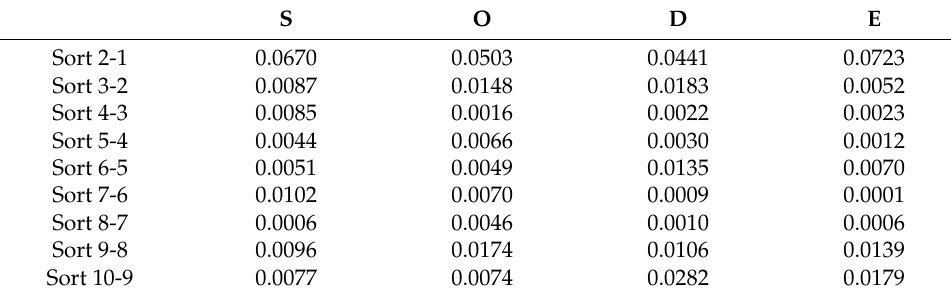
Table 5. The degree of dispersion between adjacent values in each column γ ij